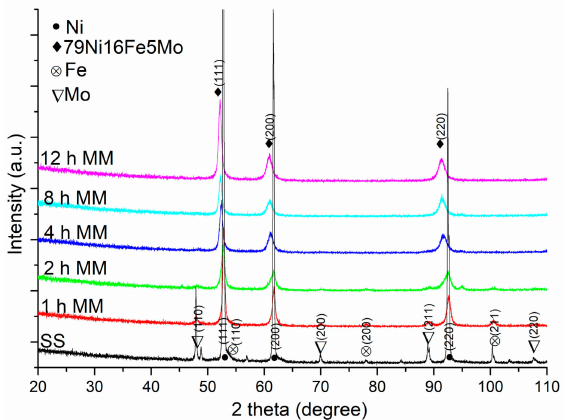
Figure 1. X-ray diffraction patterns of the as-milled samples (1, 2, 4, 8, 12 h) and of the starting sample (ss—0 h milled). For clarity, the XRD patterns have been shifted